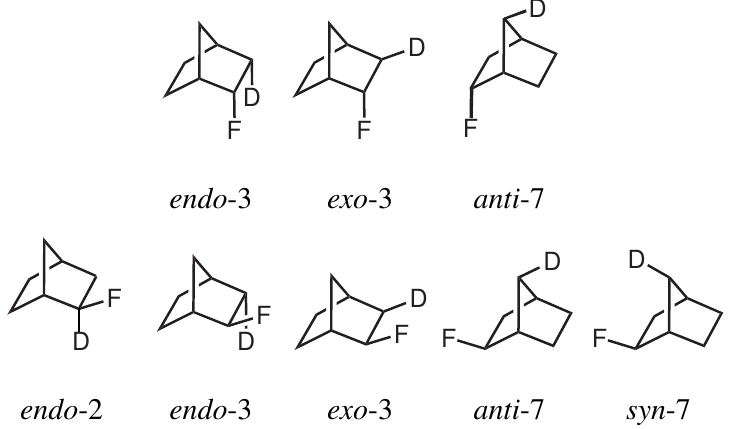
Figure 2. endo -2-Fluoronorbornane ( top ) and exo -2-fluoronorbornane ( bottom ) with deuterium labels in various positions.